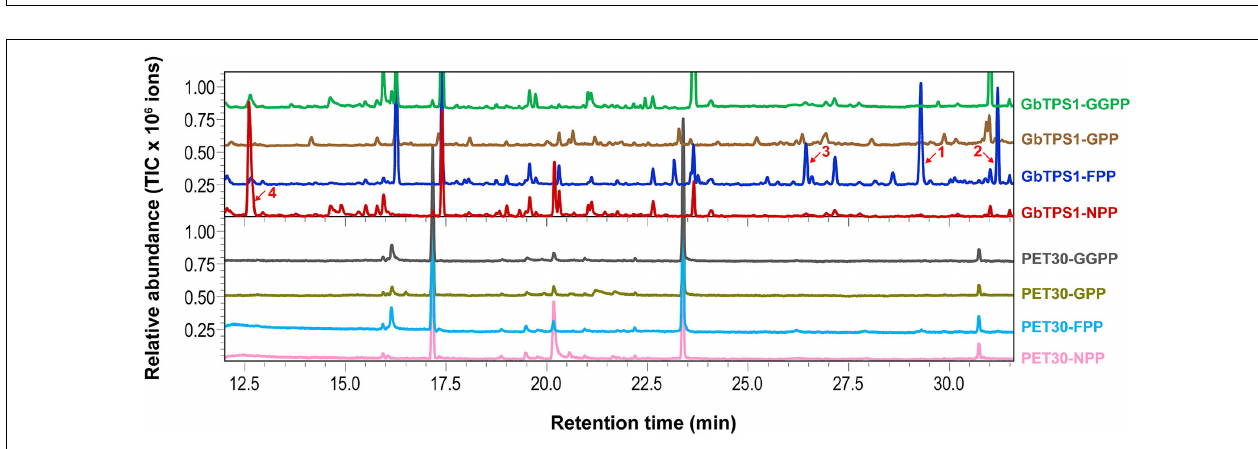
FIGURE 5 | Gas chromatography-mass spectrometry analysis of the products catalyzed by recombinant GbTPS1. 1, selinene; 2, α -gurjunene; 3, β -elemene; 4, limonene. Other peaks are contamination.